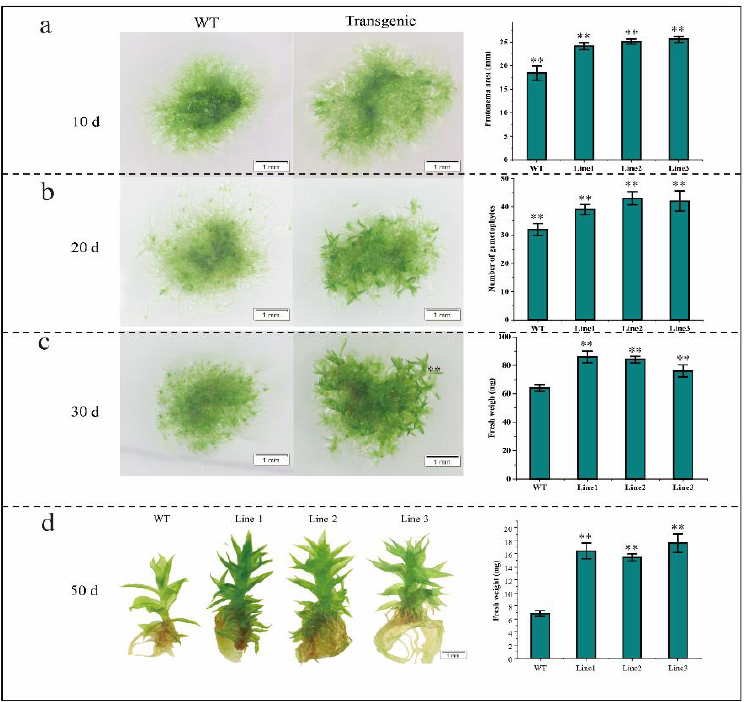
Figure 5. Phenotype of wild-type and BaZFP1 -overexpressing lines of phenotype and data statistics in P. patens . ( a ) The growth phenotype of P. patens protonema transferred to KNOP medium for growth for 10 days, protonema area statistics; ( b ) the phenotype growth for 20 days, number of gametophytes statistics; ( c ) the phenotype growth for 30 days, length of gametophyte statistics; ( d ) the P. patens protonema were transferred to KNOP medium for growth for 50 days, phenotype and length statistics of gametophytes. Three independent biological replicates were performed, and vertical bars refer to ± SD (n = 3). Asterisks indicate significant differences between the WT and the individual transgenic lines (* p < 0.05; ** p < 0.01).